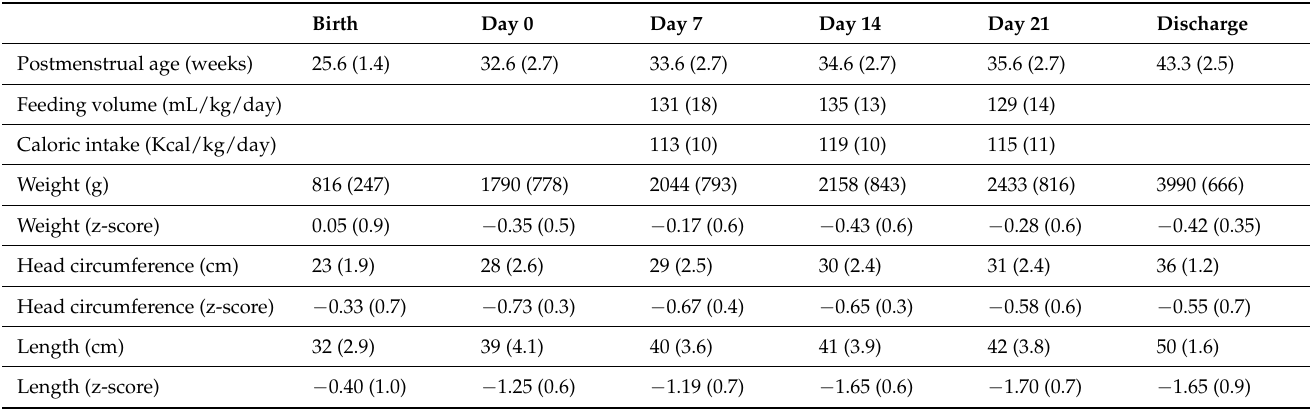
riod, but all blood cultures were negative, and no one was diagnosed with necrotizing enterocolitis. Four infants received blood transfusions during the study for anemia of prematurity according to the institution protocol. Each infant had a normal fasting glucose level (3.6 mmol/L to 5.6 mmol/L) while on full enteral feedings before study entry, and additional nutritional labs were not obtained during the study. Table 2. Growth and nutrition parameters are provided as mean (SD) for the infants at birth, on the given study days, and at discharge (N = 8).